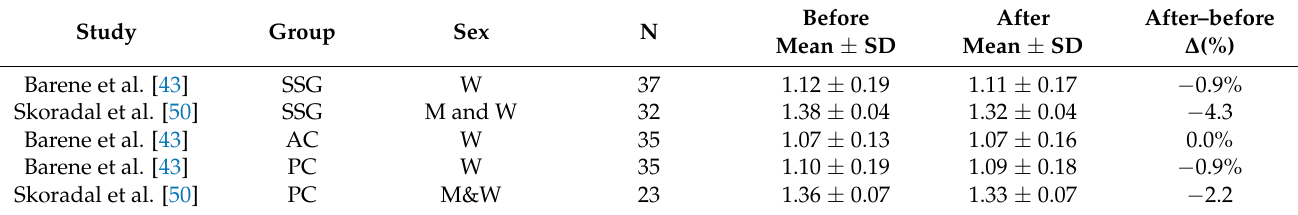
Table 7. Summary of the included studies and results of spine BMD before and after the intervention.